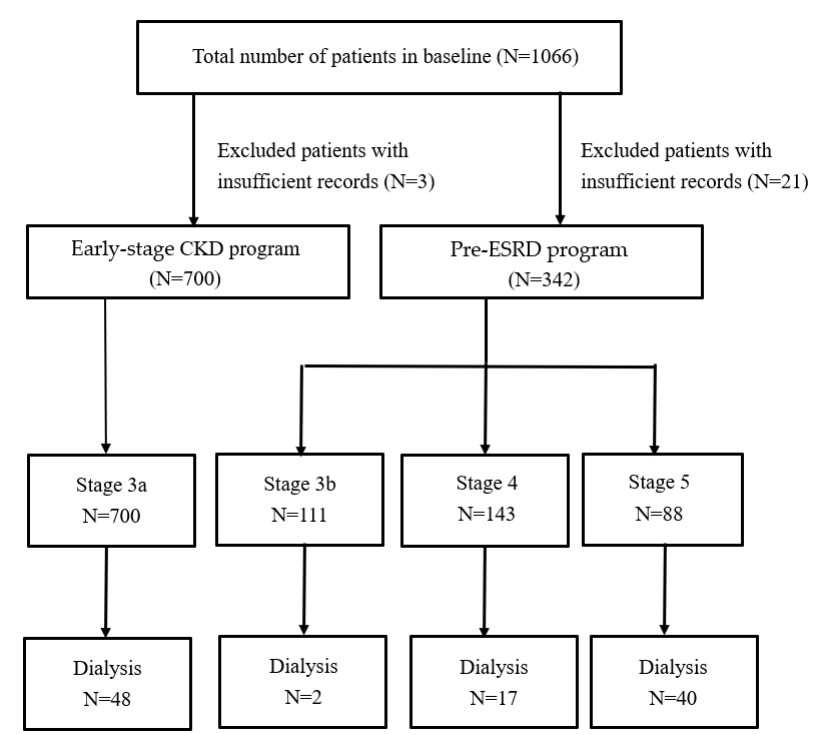
Figure 1. Flow chart for the selection of the study subjects.